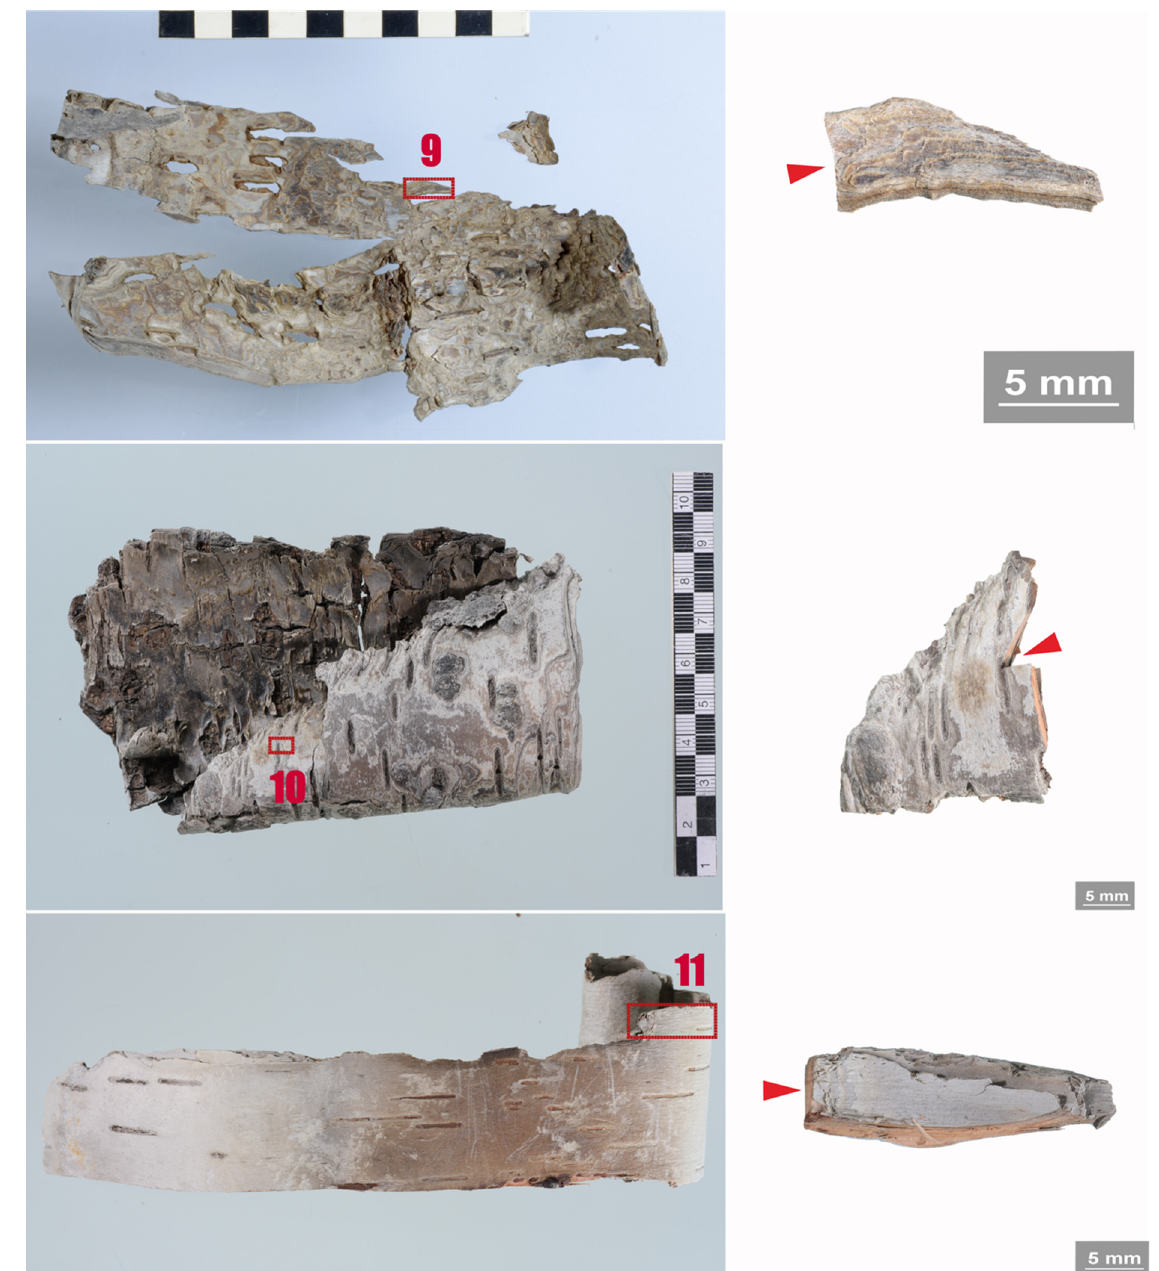
Figure 5. Left: Lendbreen fragments; right: analysed samples. Sample 9 was taken from a weathered fragment; lenticels were fully eroded but sample was not brittle. Surface and cambium side were grey and faded. Cut surface was dark brown with a few reddish-brown areas. Sample 10 was taken from a rolled birch bark fragment, stiff but not brittle, with delaminated areas and large cracks. Cambium side (outer side in image) was compact and with a light, mainly grey-brown and white colour. Some holes from insect damage were present and normally elevated lenticels were recessed. On cut surface, outer layers were grey-brown, and only inner layers still exhibited original red-brown colour. Sample 11 was taken from a long narrow strip rolled on one end. Fragment was very strong, hard to cut and still pliable. Surface was weathered, coloured matte whitish-grey; red and brown colours were missing. Cut surface revealed unaltered colours in inner layers and grey outer layers.